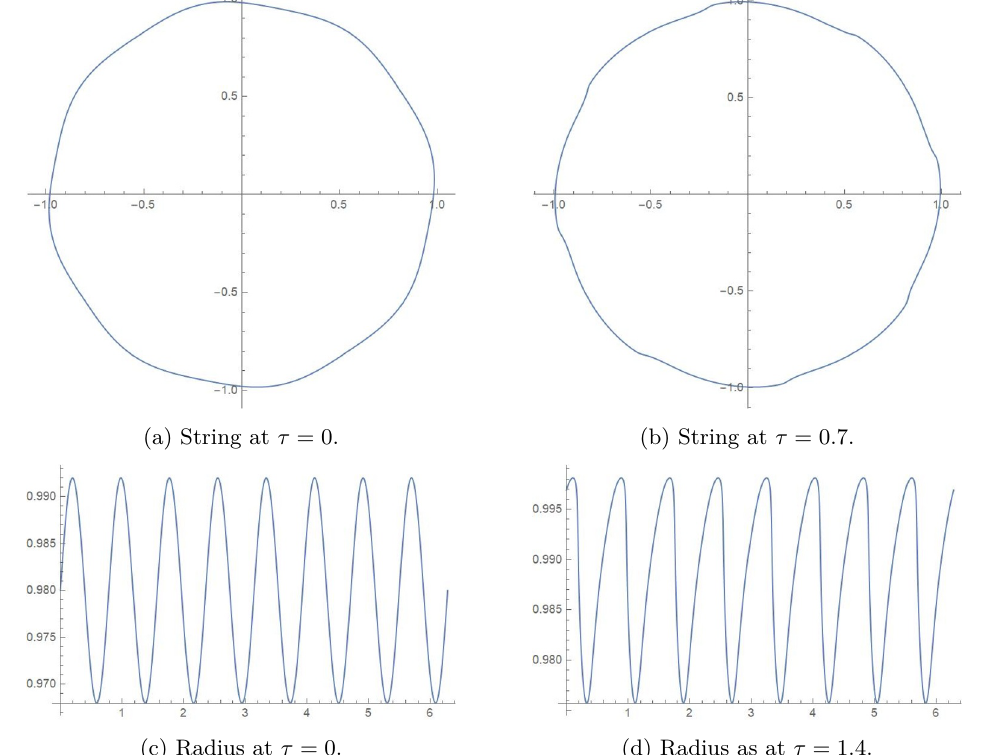
Figure 5 . Numerical example with Ml > L , showing that this bound need not hold for strings that expand indefinitely towards the horizon. Initial conditions are r (0 , σ ) = 0 . 012 sin 8 σ + 0 . 98 and ˙ r (0 , σ ) = 0 . 03 cos 8 σ . The axes give the dimensionless coordinate distance r/l , with horizon at r/l = 1 . One can see how the string moves towards the horizon and how in doing so the outer extrema get slowed down most, while the inner parts continue to